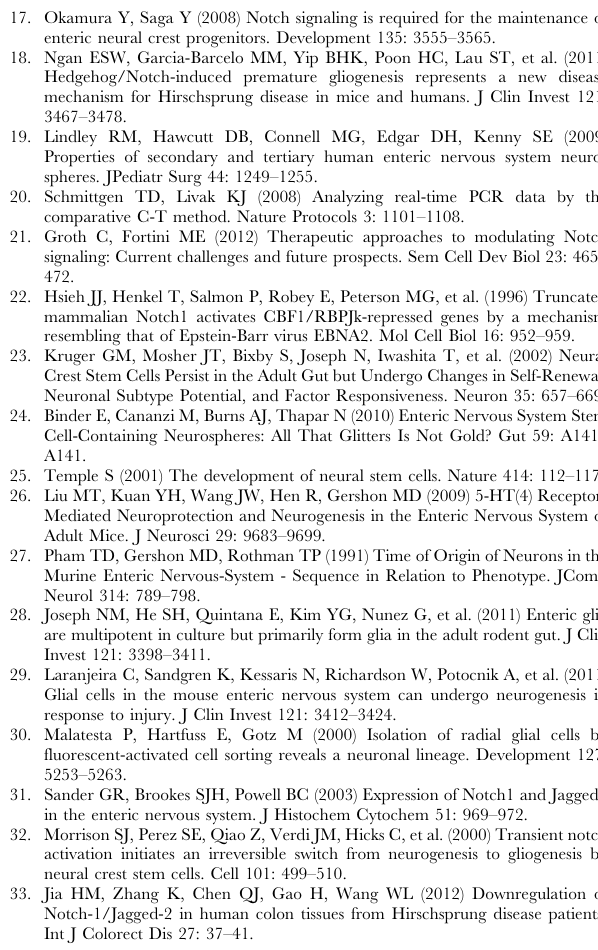
Figure S2 Double labeling of neurosphere cells for neural cell markers and EdU incorporation. Primary mouse neurospheres previously cultured for 15 days under non- adherent conditions were labeled with a 1 h pulse of 10 m M EdU. The neurospheres were then dissociated and allowed to attach after which they were fixed and permeabilized before immuno- staining for the neural cell markers shown and processing to reveal EdU incorporation. The montages shown were constructed in Adobe Photoshop from 3 separate images captured to demonstrate the EdU incorporation, immunofluorescence and phase contrast images. Scale bars = 25 m m. Figure S3 Agarose gel electrophoresis of qPCR products after DAPT treatment of neurospheres. The PCR products obtained from the experiment in Fig. 5A was electrophoresed in 2% agarose gels. Calibration standards (bp) are shown on the left hand side of each gel. PCR product sizes were: Hes1= 354 bp, Hes5= 183 bp and 269 bp and b -actin = 143 bp. The DNA in each excised band was sequenced to confirm PCR product identity; the double bands for Hes5 represent two splice variants amplified by the primer pair used.